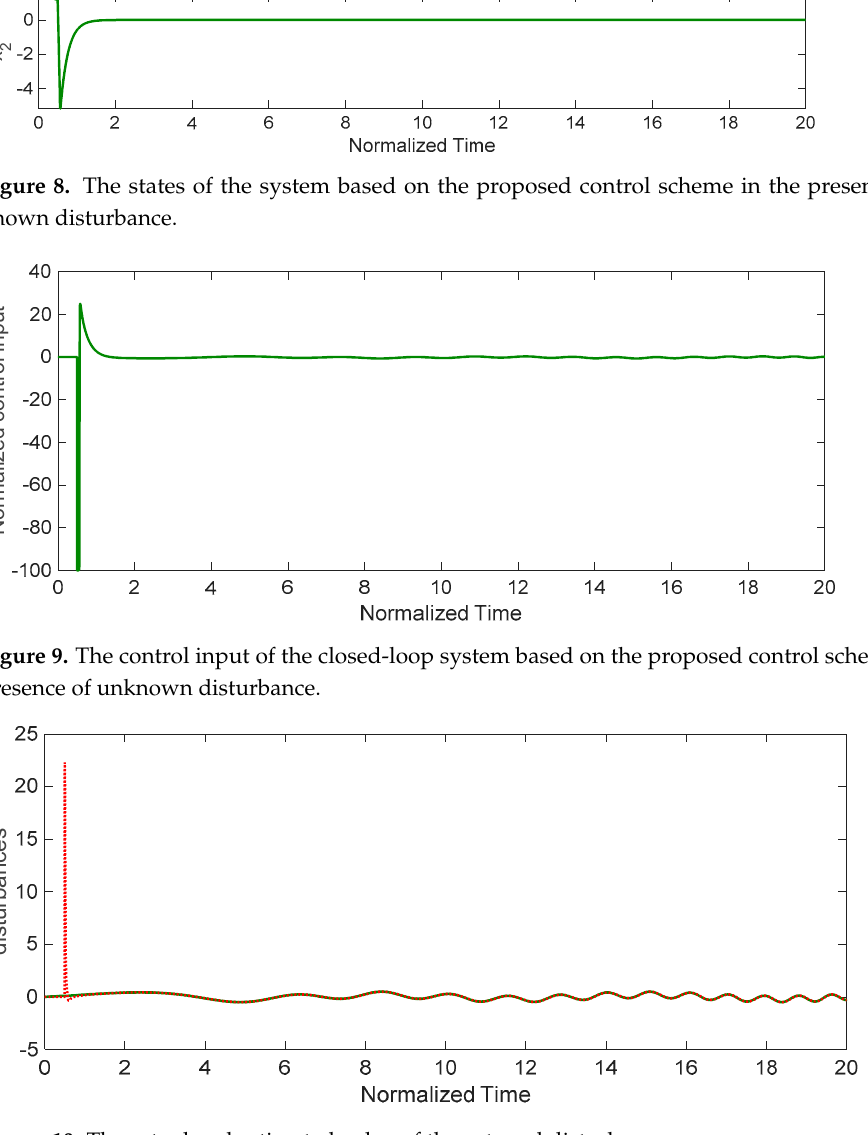
Figure 10. The actual and estimated value of the external disturbance.